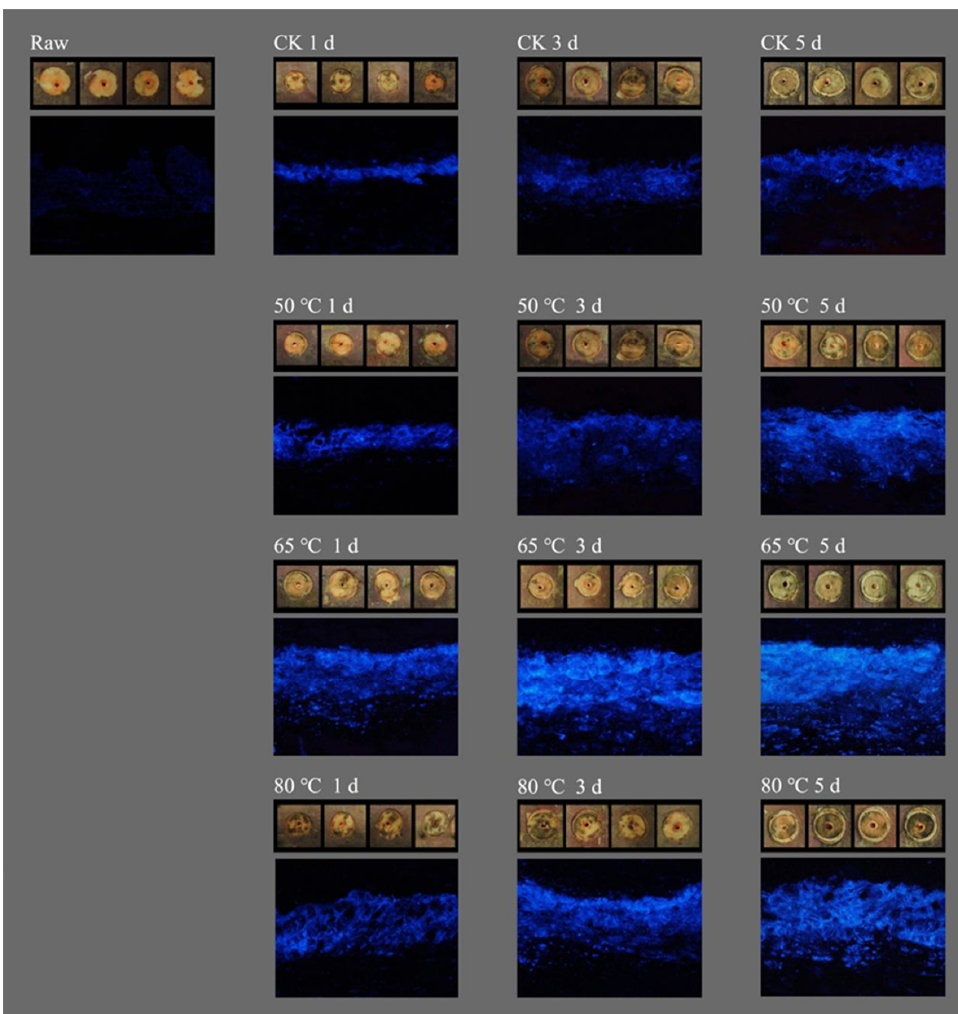
Figure 1. Effects of RHT treatments on suberin deposition in sweet potato tuber wound.